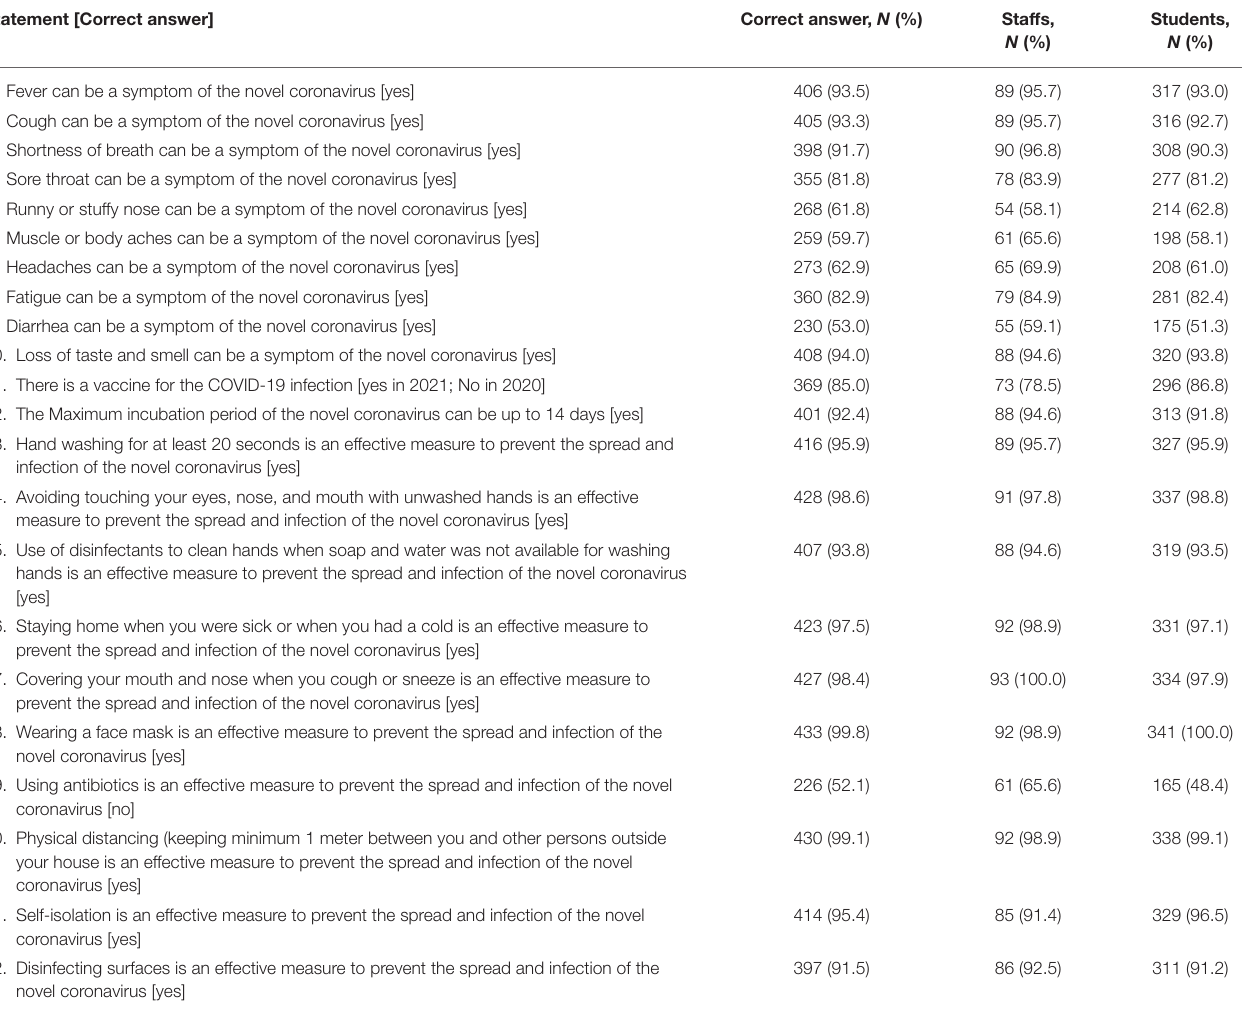
TABLE 3 | Assessment of knowledge regarding COVID-19 ( n =